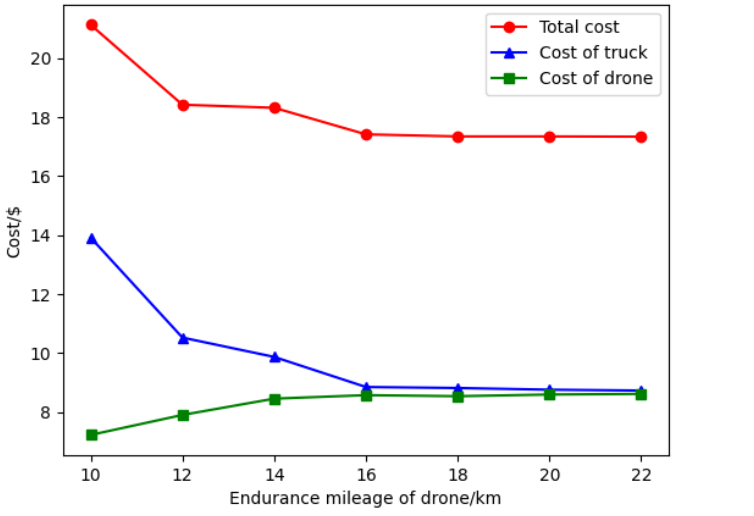
Figure 13. Experimental results under different drone